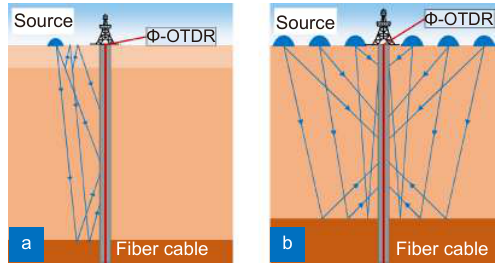
Fig. 3 | Operation principle of Φ-OTDR based VSP monitoring system. ( a ) Zero-offset VSP. ( b ) Walk-away VSP.